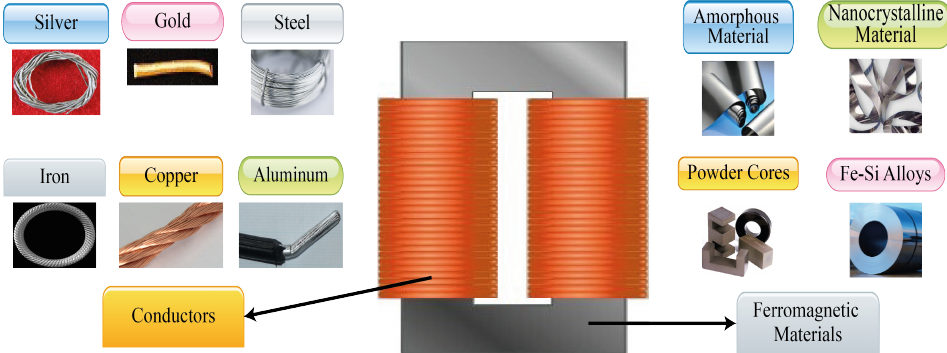
Figure 1. Ferromagnetic and conductor materials types. Source: Adapted from [33–43]. Fe-Si alloys are alloys based on Fe with small quantities of Si (not more than 4.5%). These alloys are attractive due to their reasonable cost and magnetic properties [44]. There are two kinds: grain non-oriented sheets (GNO) and grain-oriented sheets (GO) [30]. At present, GO material represents 80% of the electrical devices market